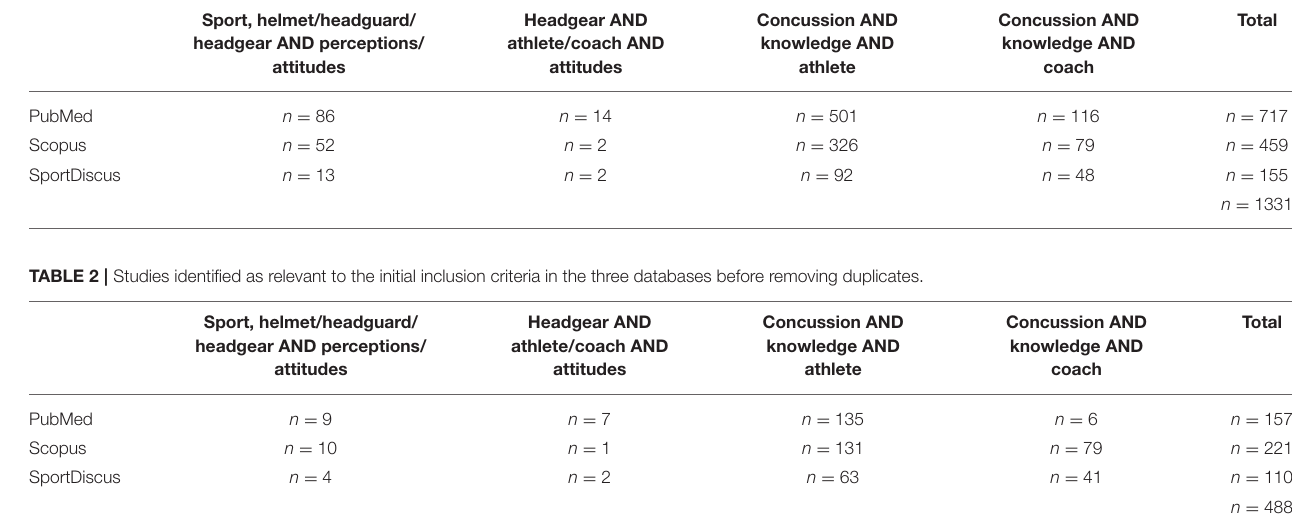
TABLE 1 | Search strategies and initial number of hits. Sport, helmet/headguard/ headgear AND perceptions/ attitudes